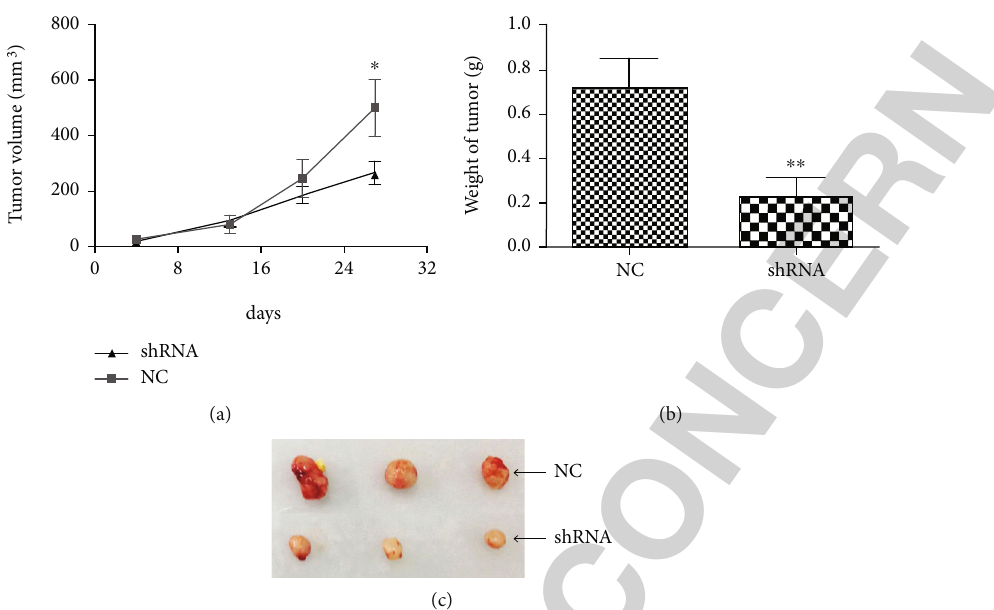
Figure 6: LOXL1-AS1 knockdown inhibited hepatocarcinoma growth in vivo. (a) Tumor growth curve. Hep-G2 cells were stably transfected with sh-LOXL1-AS1 or sh-control and then injected into nude mice ( n = 3 ), respectively. Tumor volume was calculated from day 4 after injecting tumor cells. The error bars indicated the standard deviation (SD). (b) Tumor weights were expressed as mean ± S : D when the tumors were removed from the nude mice. (c) The number and size of tumors after removing from the mice. Graph revealed mean ± SD , ∗ meant P < 0 : 05 , ∗∗ meant P < 0 : 01